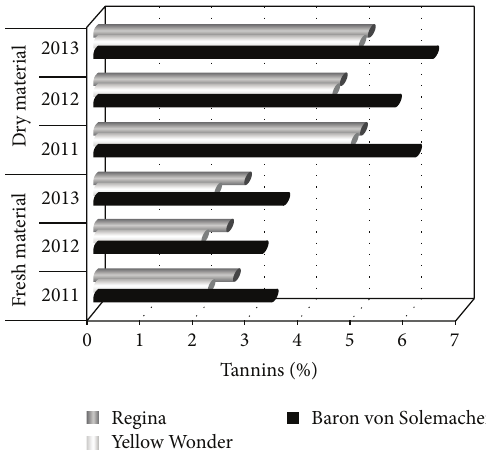
Figure 2: Content of phenolic acids (as caffeic acid) mg ⋅ g −1 in raw material in successive years of the study.